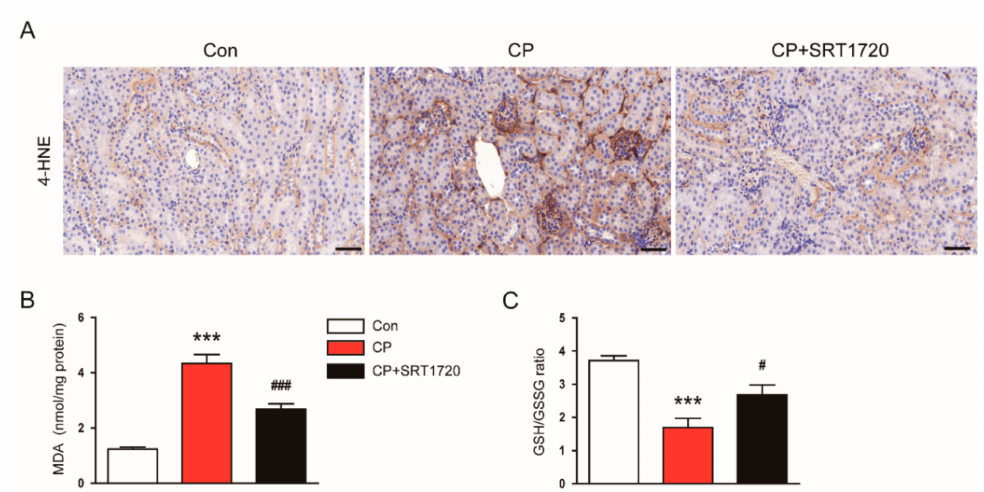
Figure 6. E ff ects of SRT1720 on renal oxidative damage in mice treated with cisplatin. ( A ) Representative images of immunohistochemical staining using anti-4-hydroxynonenal (4-HNE) antibody. Scale bar: 50 µ m. ( B ) Renal malondialdehyde (MDA) level. ( C ) reduced glutathione (GSH) / oxidized glutathione (GSSG) ratio in kidneys. *** p < 0.001 vs. Con. # p < 0.05 and ### p < 0.001 vs. CP.